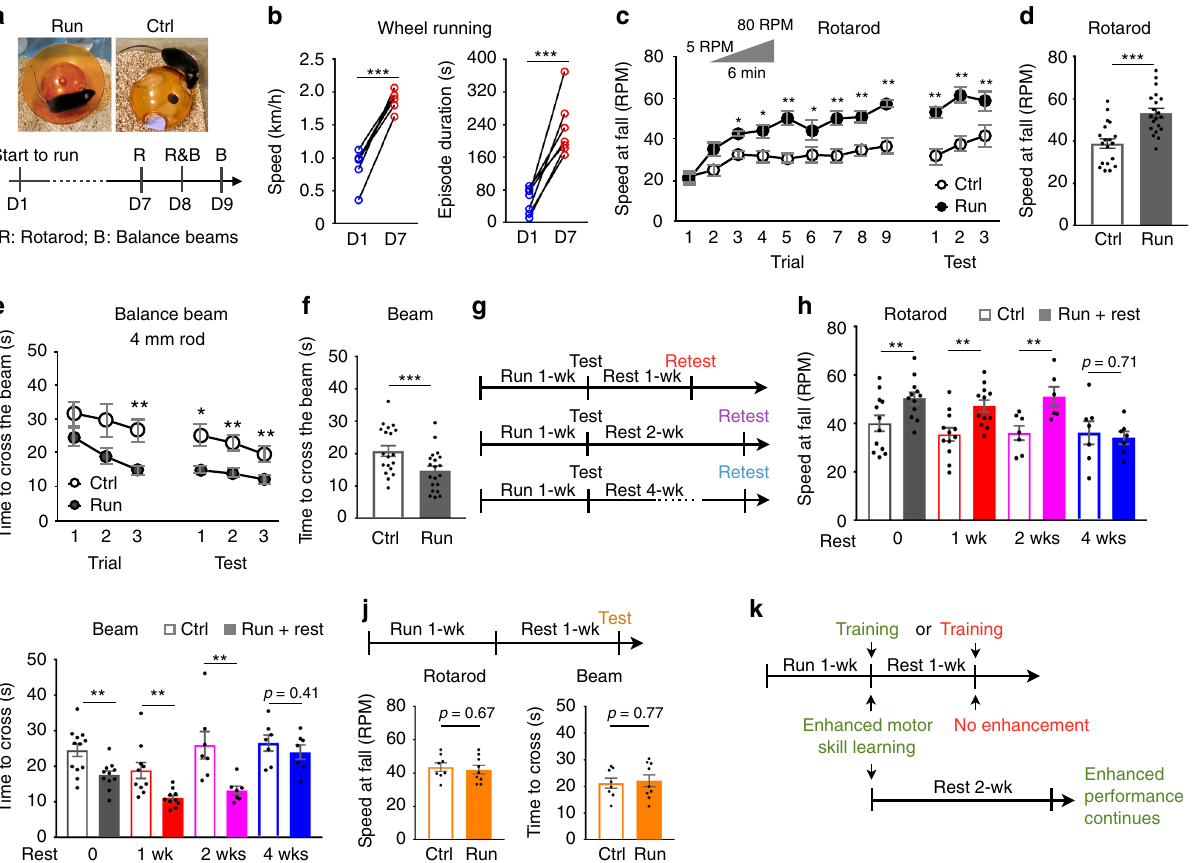
Fig. 1 Sustained running enhances motor skill learning. a Top: Runner mice were housed with running wheels and control mice with wheelbases. Bottom: timeline for running and behavioral tests. b Mean speed (left, n = 6 animals per group) and mean episode duration (right, n = 7 animals per group) of running on day 1 (naive) or day 7 (1-week trained). c Speed at fall on an accelerative rotarod of each trial during training or each test the day after training. d Mean speed at fall on this rotarod in three tests on the day after training. e Time to cross a 1-m long, 4-mm diameter rod balance beam during each trial of training or each test the day after training. f Mean time to cross this balance beam in three tests the day after training. For c – f , n = 19 Ctrls and 20 Runners. g Timelines for immediate behavioral testing and retesting. h , i Mice that had run for 1 week or non-runner controls were tested with ( h ) rotarod and ( i ) balance beam (4 mm rod). After rest for 1, 2 or 4 weeks, mice were retested. For h , n = 12 animals per group for 0 and 1 week, 7 Ctrls and 6 Runners for 2 weeks, and 7 per group for 4 weeks. For i , n = 12 animals per group for 0 week, 10 for each group for 1 week, 7 per each group for 2 and 4 weeks. j Top: timelines for delayed behavioral testing. Bottom: performances on rotarod (left) and balance beam (right, 4 mm rod) after 1 week of running followed by 1 week of rest compared to controls that never ran. n = 8 animals for Ctrl and 9 for Run + Rest. k Time dependence of enhanced motor skill learning. When motor skills are trained (green) immediately after 1 week of running, runner mice show enhanced learning. Enhancement of acquired motor skills is sustained for at least two weeks. When motor skills are trained (red) after 1 week of running followed by 1 week of rest, no enhancement in learning is observed. Statistical signi fi cance * p < 0.05, ** p < 0.01, *** p < 0.001 was assessed by two-sided paired t -test ( b ) or two-sided Welch ’ s t -test (other panels). Data shown are mean ±